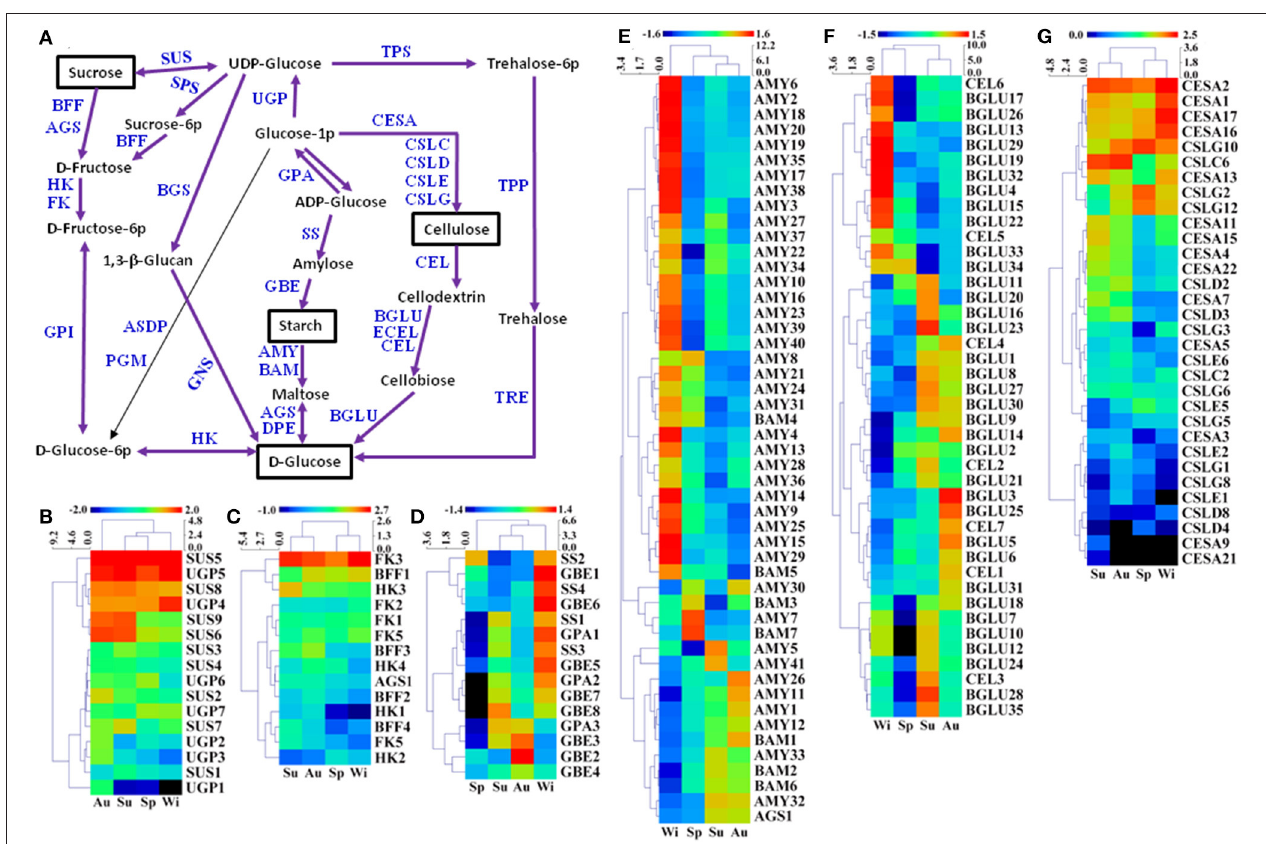
FIGURE 8 | A putative model of starch and sucrose metabolism (referring to the KEGG pathway map00500) in T. hemsleyanum FD-TRs (A) and heatmaps representing expression dynamics of genes involved in sucrose biosynthesis (B) , sucrose degradation (C) , starch biosynthesis (D) , starch degradation (E) , cellulose degradation (F) , and cellulose biosynthesis (G) . AGS, α -glucosidase; AMY, α -amylase; ASDP, ADP-sugar diphosphatase; BAM, beta-amylase; BFF, beta-fructofuranosidase; BGLU, beta-glucosidase; BGS, 1,3-beta-glucan synthase; CEL, endoglucanase; CESA, cellulose synthase A; CSLC-CSLG, cellulose synthase-like protein C-G; DPE, 4- α -glucanotransferase; ECEL, cellulose 1,4-beta-cellobiosidase; FK, fructokinase; GBE, 1,4- α -glucan branching enzyme; GNS, glucan endo-1,3-beta-glucosidase; GPA, glucose-1-phosphate adenylyltransferase; GPI, glucose-6-phosphate isomerase; HK, hexokinase; PGM, phosphoglucomutase; SPS, sucrose-phosphate synthase; SS, starch synthase; SUS, sucrose synthase; TPP, trehalose 6-phosphate phosphatase; TPS, trehalose 6-phosphate synthase/phosphatase; TRE, α , α -trehalase; UGD, UDP-glucose 6-dehydrogenase; UGP, UTP-glucose-1-phosphate uridylyltransferase.